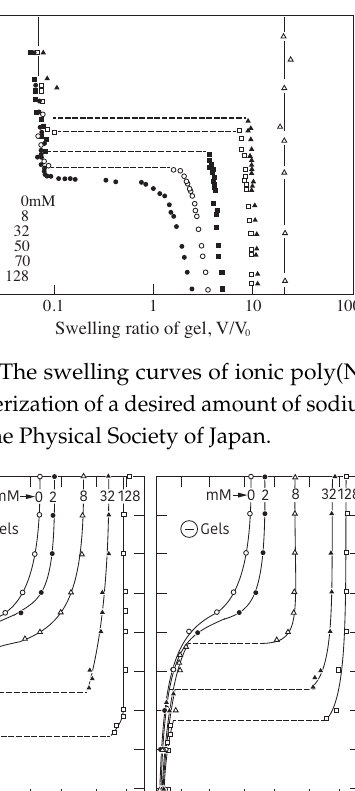
Figure 3. The swelling curves of non-ionic poly(N-isopropylacrylamide) gels. Reproduced with permission from Ref. [8]. © 1986, The Physical Society of Japan.